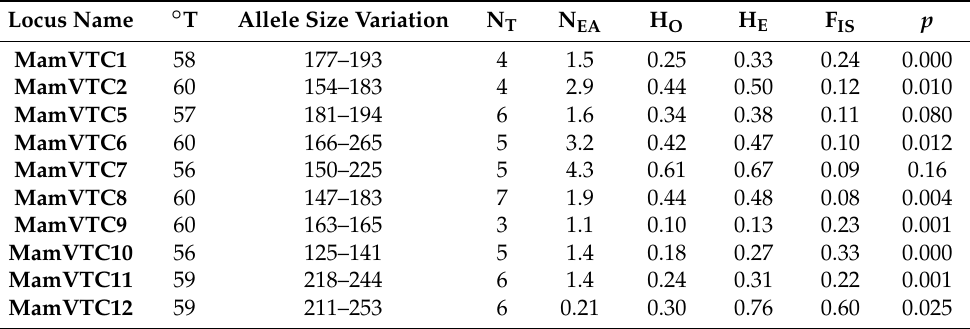
Table 1. Genetic diversity described for M. albiflora based on 10 polymorphic loci and 96 individual samples across four patches. The table indicates the specific alignment temperature for each locus; total number of alleles (N T ); the effective number of alleles; the observed heterozygosity (H O ) and expected heterozygosity (H E ) by locus; inbreeding coefficient (F IS ); and the p -value < 0.05 after Bonferroni correction indicates Hardy-Weinberg